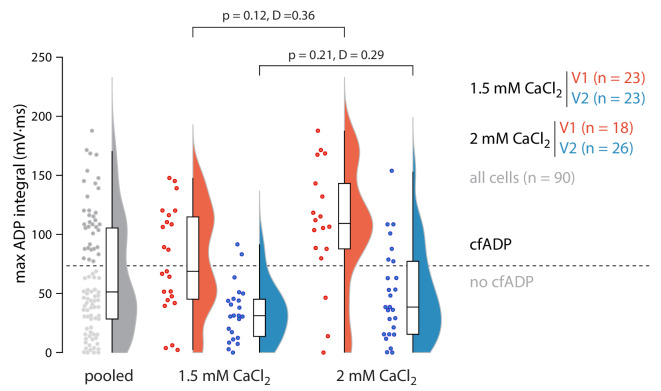
Maximum ADP integral for all cells split by recording ACSF containing either 1.5 or 2 mM CaCl2.p and D values are shown for a two-sample Kolmogorov-Smirnov test. All cells recorded during this study in 1.5 mM CaCl2 are included.